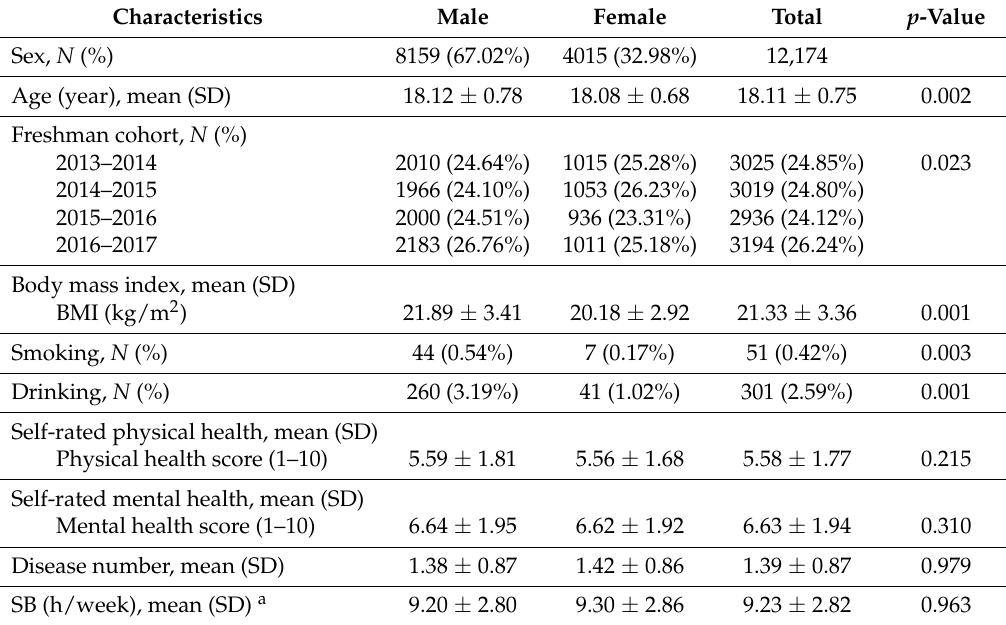
Table 1. Baseline characteristics of survey